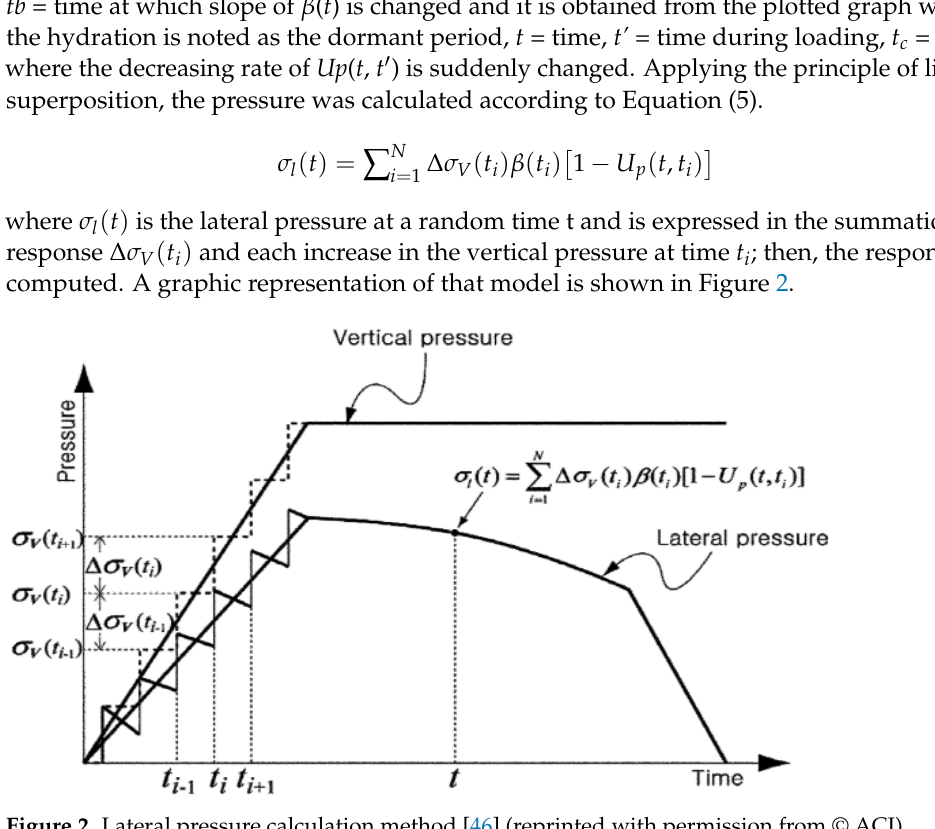
Figure 2. Lateral pressure calculation method [46] (reprinted with permission from © ACI).